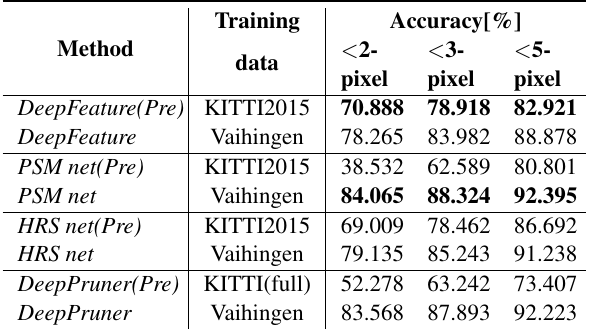
Table 4. Evaluation of deep learning based methods on fine tune dataset.